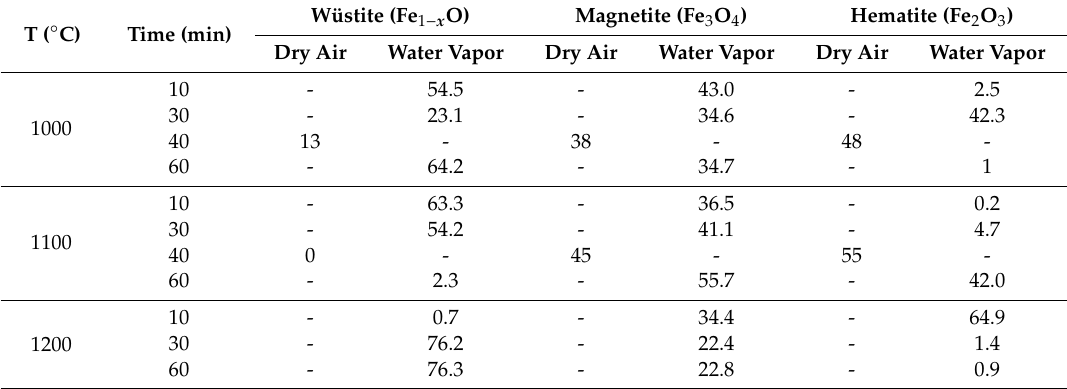
Figure 10. X-ray di ff raction patterns of oxide scales formed under dry air and water vapor conditions. Table2.